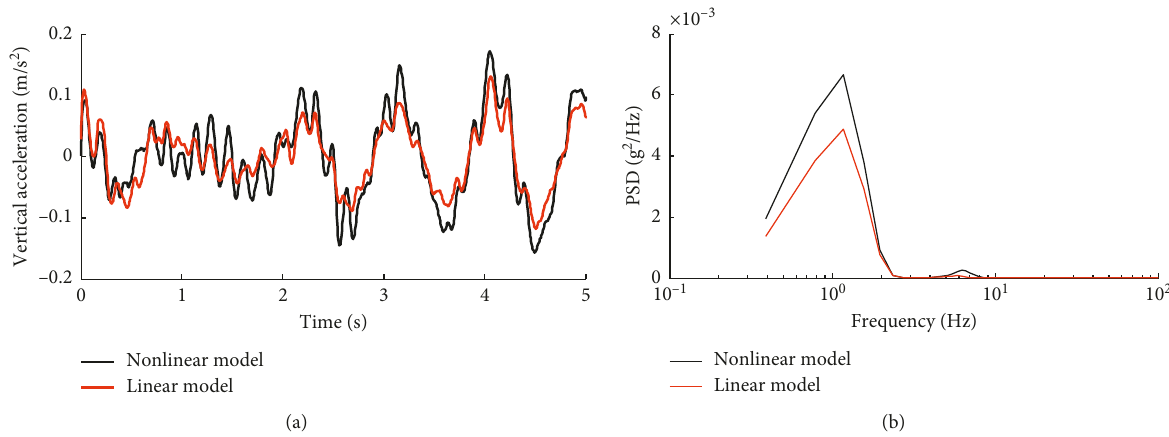
Figure 3: Comparison of the vertical acceleration of the car body between the linear model and the nonlinear model in the (a) time domain and (b) frequency